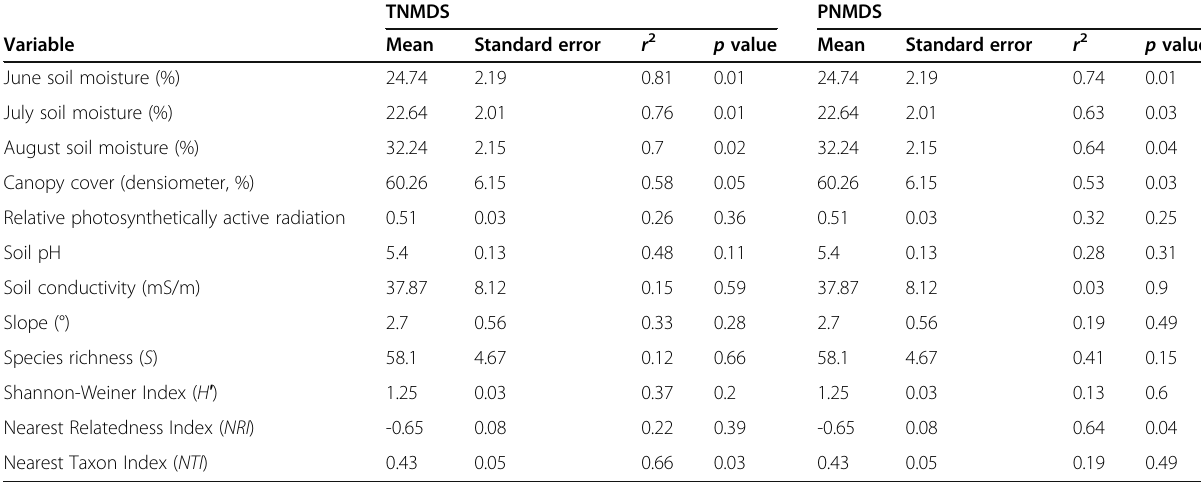
Table 2 Vector analysis of all environmental variables and diversity indices for TNMDS and PNMDS ordinations (Fig. 3a,